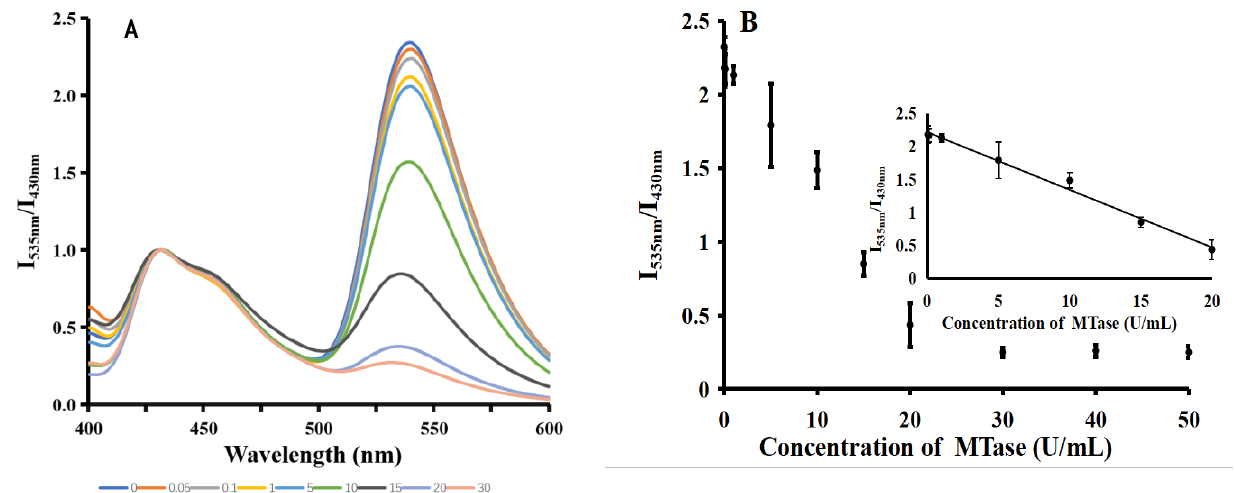
Figure 3. ( A ) Fluorescence emission spectra in the presence of increasing amounts of MTase (0, 0.05, 0.1, 1, 5, 10, 15, 20, 30 U/mL). ( B ) The relationship between fluorescence ratios and MTase activity. Error bars were estimated from three replicate measurements. The inset shows the linearity of the fluorescence ratios with respect to MTase concentrations (R 2 = 0.9907). Table 1. Comparison of reported methods for MTase detection.